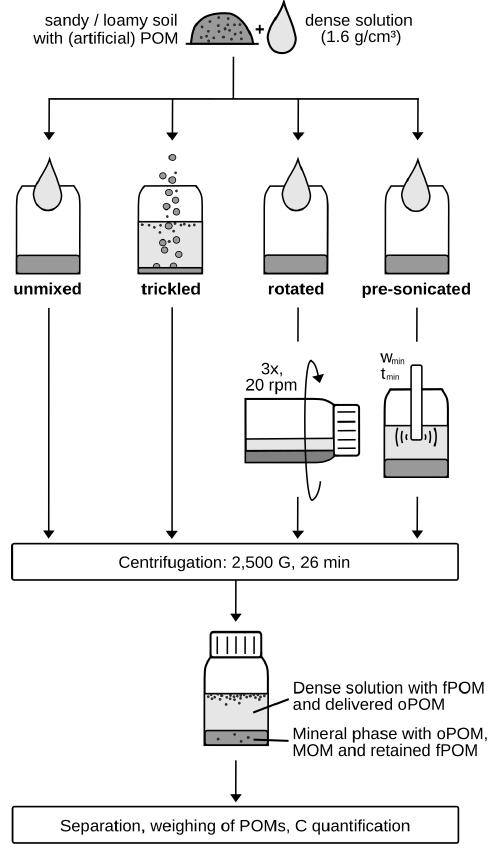
Figure 1. Separation of free particulate organic matter (fPOM) from mineral soil matrices and occluded particulate organic matter (oPOM). Four different treatments were used (unmixed, trickled, rotated three times with 20rpm, and swirled up by pre-sonication using a minimum of mechanical stress w min and application time t min ) and applied in both the simple and complex scenario.